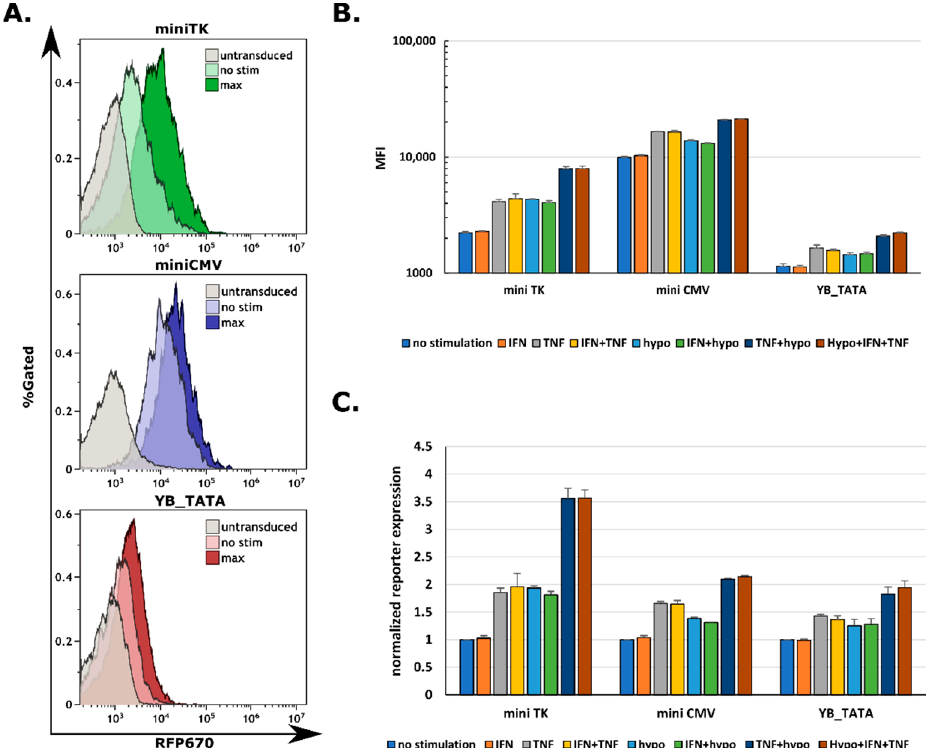
Figure 4 . An additive response is observed in human primary T-cells for all three minimal promoters: ( A ) Representative FACS plots of the indicated promoter’s background and maximum induction rate of the RFP670. ( B ) Average from triplicates of MFI of the ZsGreen positive fraction; error bars indicate standard deviation. ( C ) Reporter expression fold change, average of triplicates from the ZsGreen positive fraction, error bar indicates standard deviation c. The %RFP670 + cells normalized to the ZsGreen positive cells. Average of triplicates; error bars indicate standard deviation. Data shown are ZsGreen-positive, single-discriminated, and DAPI-negative.